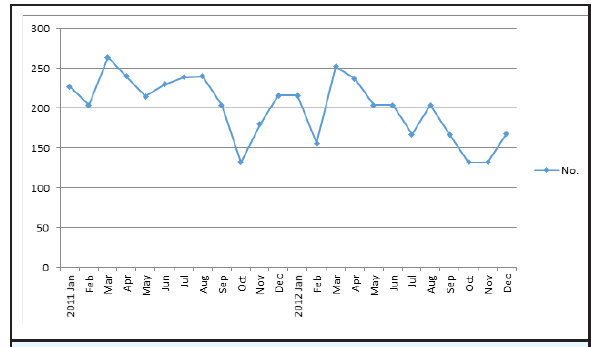
Figure 1. Monthly pattern of Abortion in